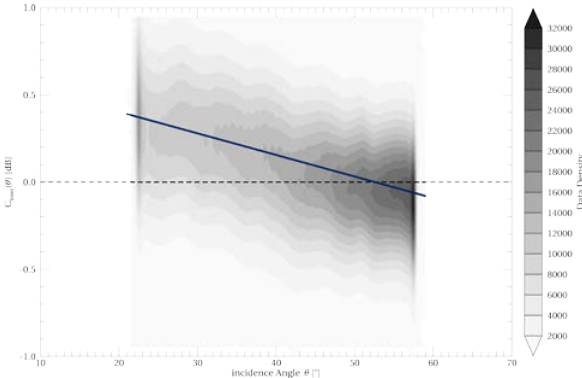
Figure 3: Radiometric difference between ESCAT and ASCAT aft-beam observations